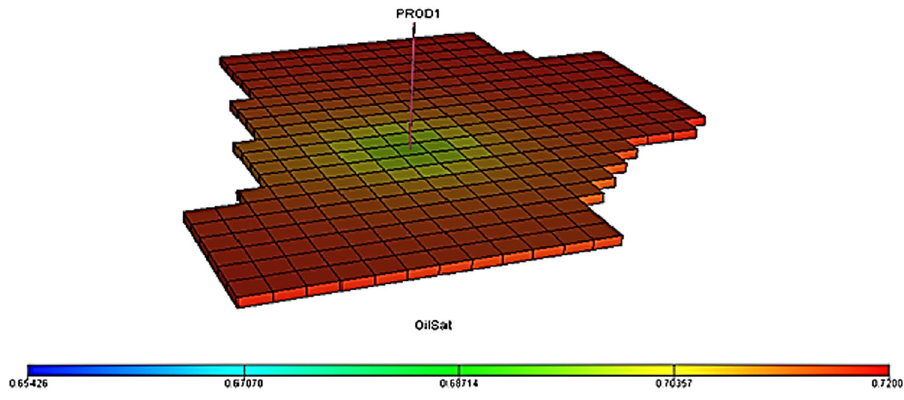
Fig. 9 Case study map surface map showing the location of